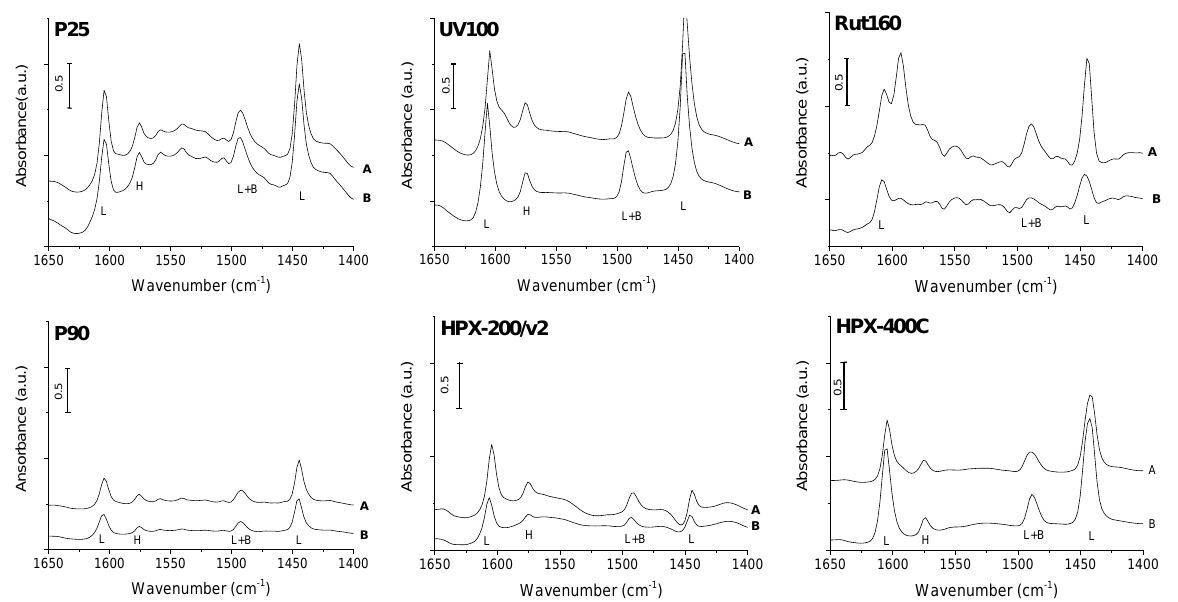
Figure 3. Infrared spectra of pyridine adsorption on P25, P90, UV100, HPX-200/v2, Rut160 and HPX-400C: (A) spectra of catalysts saturated with pyridine vapor at ambient temperature, then desorption of pyridine for 1 h at ambient temperature; (B) spectra after pyridine desorption at 150 ◦ C for 1 h (L: characteristic vibration of Lewis acid sites, B: characteristic vibration of Brønsted acid sites, L + B: vibration common to Lewis and Brønsted acid sites, H: vibration of pyridine linked by hydrogen bonds). Conditions: Prior to pyridine adsorption, TiO 2 self-supported pellets were vacuum treated for 1 h at 150 ◦ C (reference spectra), normalized spectra to 100 mg.